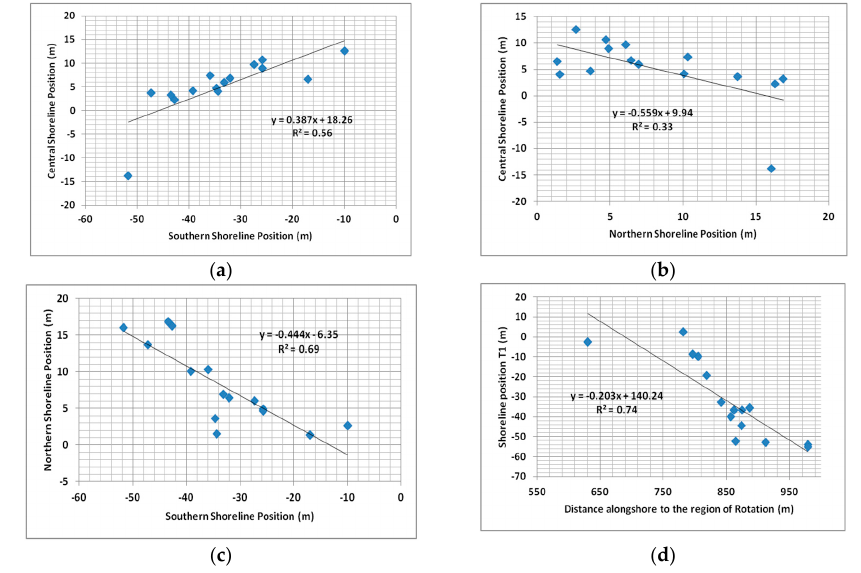
Figure 8. Spatial change 1941–2014 between, ( a ) north and south beach extremities; ( b ) central region and southern beach extremity; ( c ) central region and northern beach extremity and ( d ) Transect 1 shoreline position and the region of beach rotation.